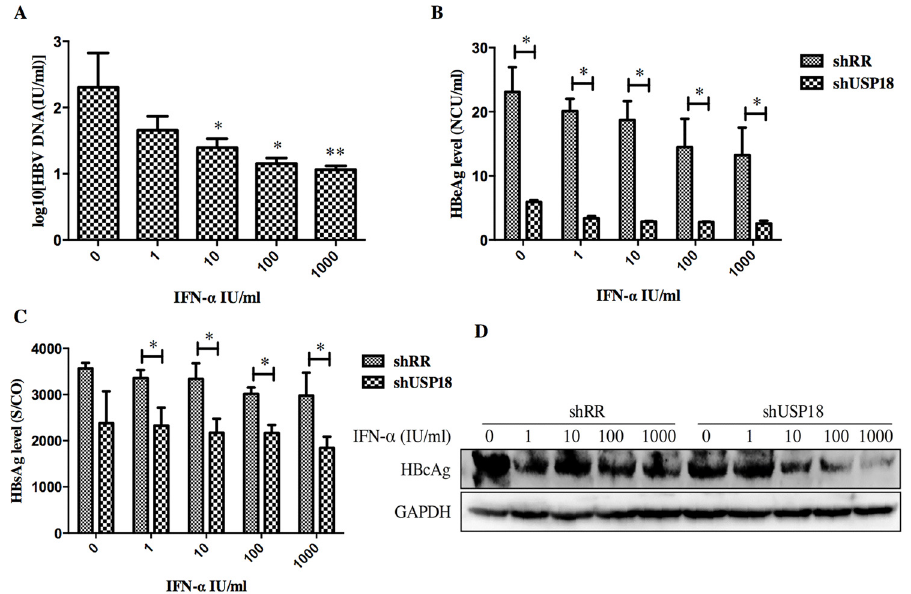
Fig 4. USP18 silencing enhances the antiviral activity of IFN- α against HBV expression in Hepg2.2.15 cells. (A) After treated with indicated dose of IFN- α (0, 1, 10, 100, 1000 IU/ml) in USP18 silenced Hepg2.2.15 cells, the supernatant was collected for detection of HBV DNA load using quantitative real-time PCR kits. (B) and (C) The levels of HBsAg and HBeAg were detected using ELISA kits. The secretion of HBV DNA, HBsAg and HBeAg was significantly inhibited by shUSP18. (D) The level of intracellular HBcAg was quantified by western blot. The results are presented as the means ± SD, n = 3, error bars indicate SD. * P < 0.05; ** P < 0.01 vs. control.